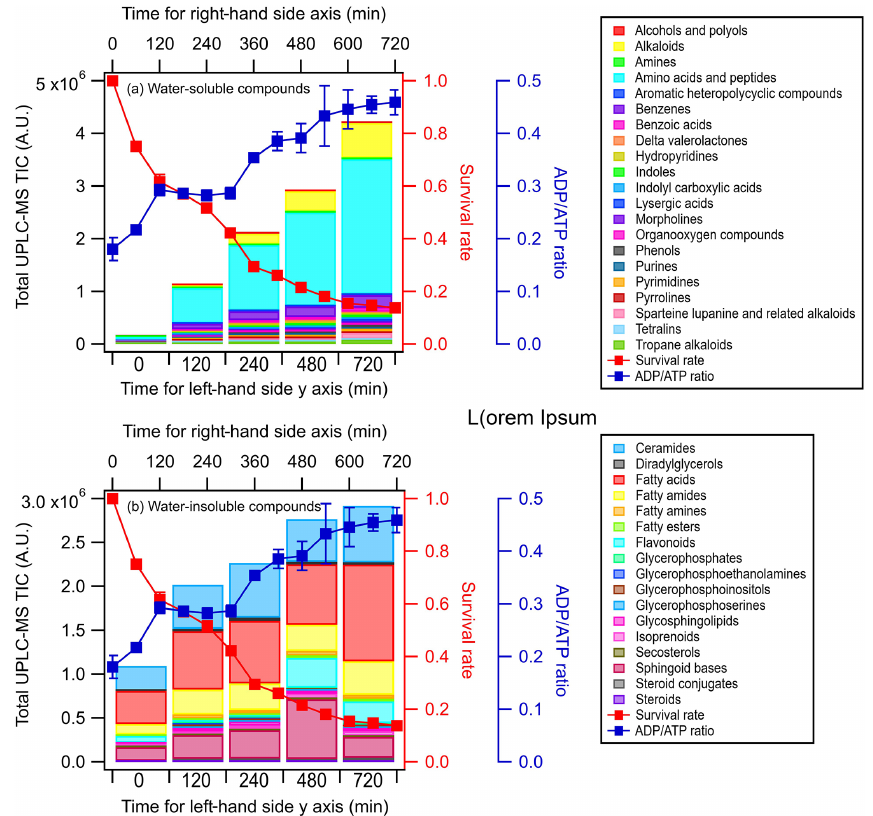
Figure 3. Time evolution of the UPLC-MS total ion chromatograph (TIC) signals of (a) water-soluble compounds and (b) water-insoluble compounds from E. hormaechei B0910 during exposure to light at pH4.3 over time. These compounds are classified based on their chemical functionality. Also shown is the time evolution of the survival rate and ADP / ATP ratio of E. hormaechei